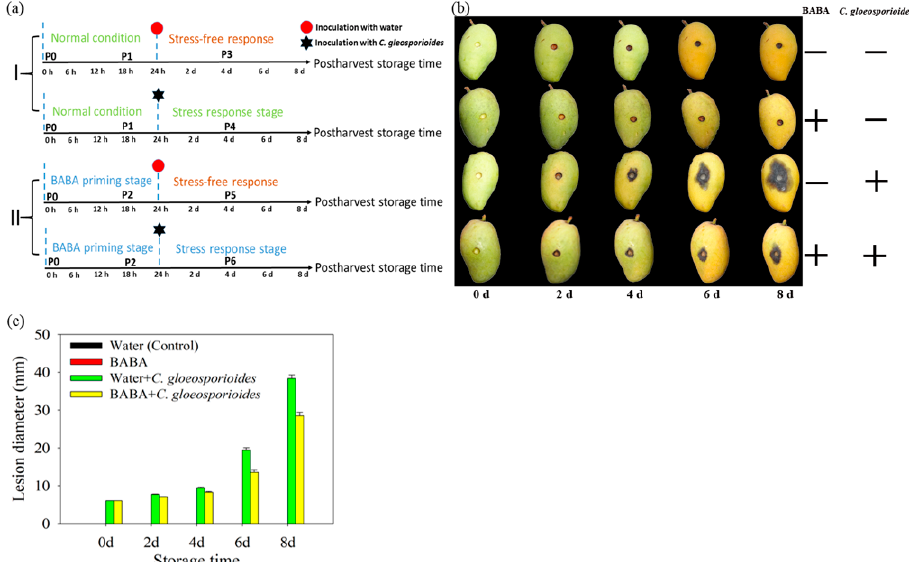
Figure 1. Outline of the platform used for β -aminobutyric acid (BABA)-priming mechanism investigation. ( a ) Mango fruit were non-primed ( I ) or BABA-primed ( II ) before inoculation of C. gloeosporioides during postharvest storage; ( b ) Visual image of anthracnose disease in mango fruit after di ff erent treatments; ( c ) Lesion diameter of mango fruit after di ff erent treatments.